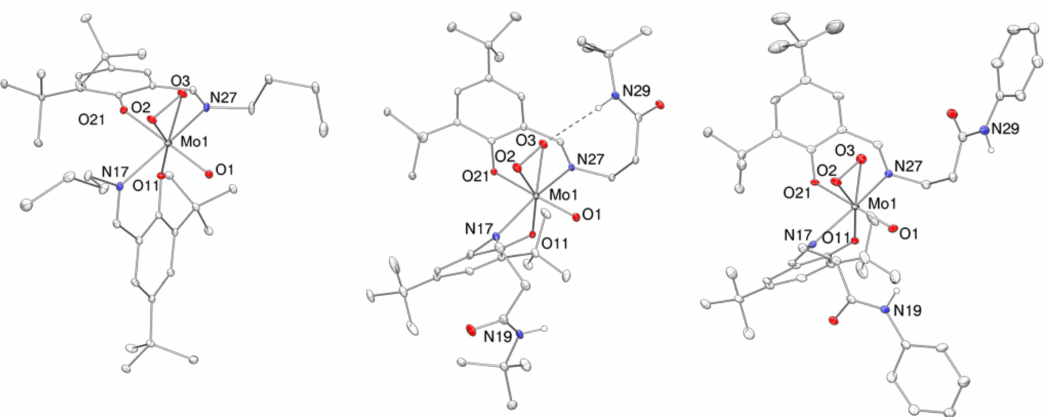
Figure 4. Molecular views (50% probability level) of the oxido peroxido molybdenum(VI) complexes [MoO(O 2 )( L1 ) 2 ] ( 9 , left), [MoO(O 2 )( L2 ) 2 ] ( 10 , middle) and [MoO(O 2 )( L3 ) 2 ] ( 11 , right). H atoms, except